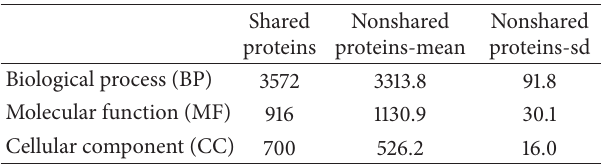
Table 2: Number of GO terms for each of the three gene ontologies, for shared and nonshared proteins, in nested